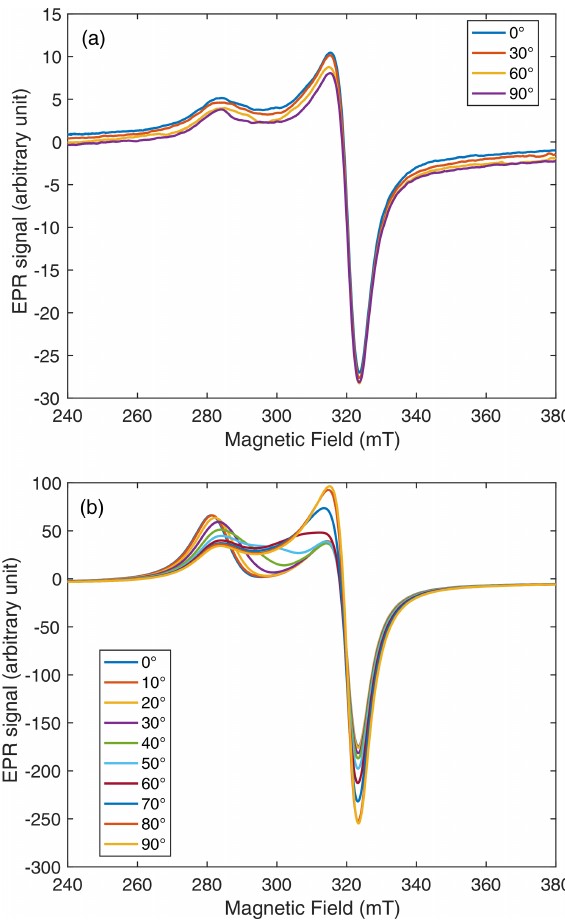
Figure 6. EPR spectra of a film deposited with an applicator upon rotation about (a) the z axis and (b) the Y axis, at different angles β 0 between the magnetic field and (a) the X axis or (b) the z axis. The rotation axis is Y 0 . The sample was set with Z (cid:107) Y 0 in case (a) and with Y (cid:107) Y 0 in case (b) .